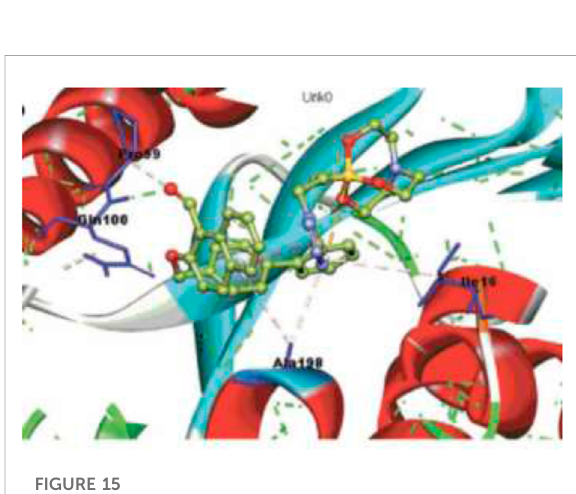
FIGURE 15 Binding pattern of 165 with InhA. Reproduced from Singh et al.,